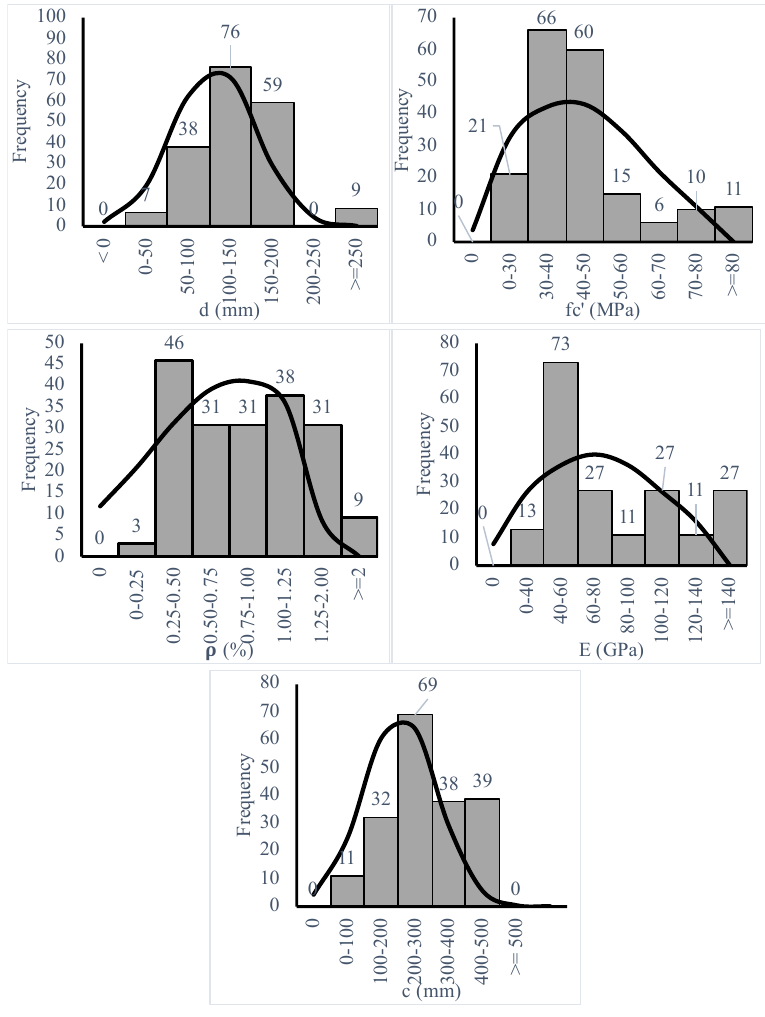
Figure 1. Frequency spectrum of different